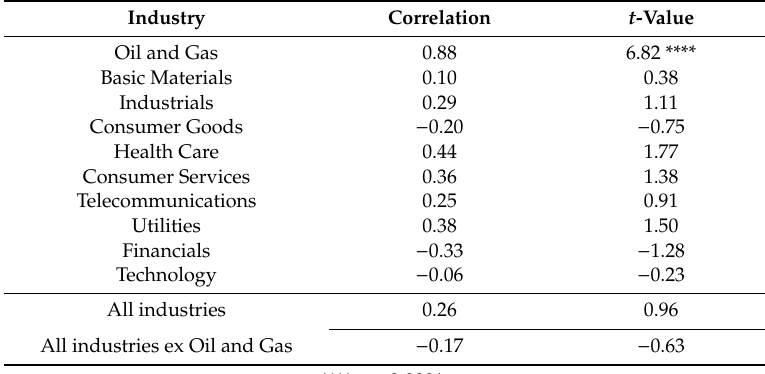
Table A2. Correlations between the operating cash flow of each industry and the GPCF. Each company’s cash flow weighted individually with the weights in the FTSE GAISAC index, scaled to correct for missing observations.